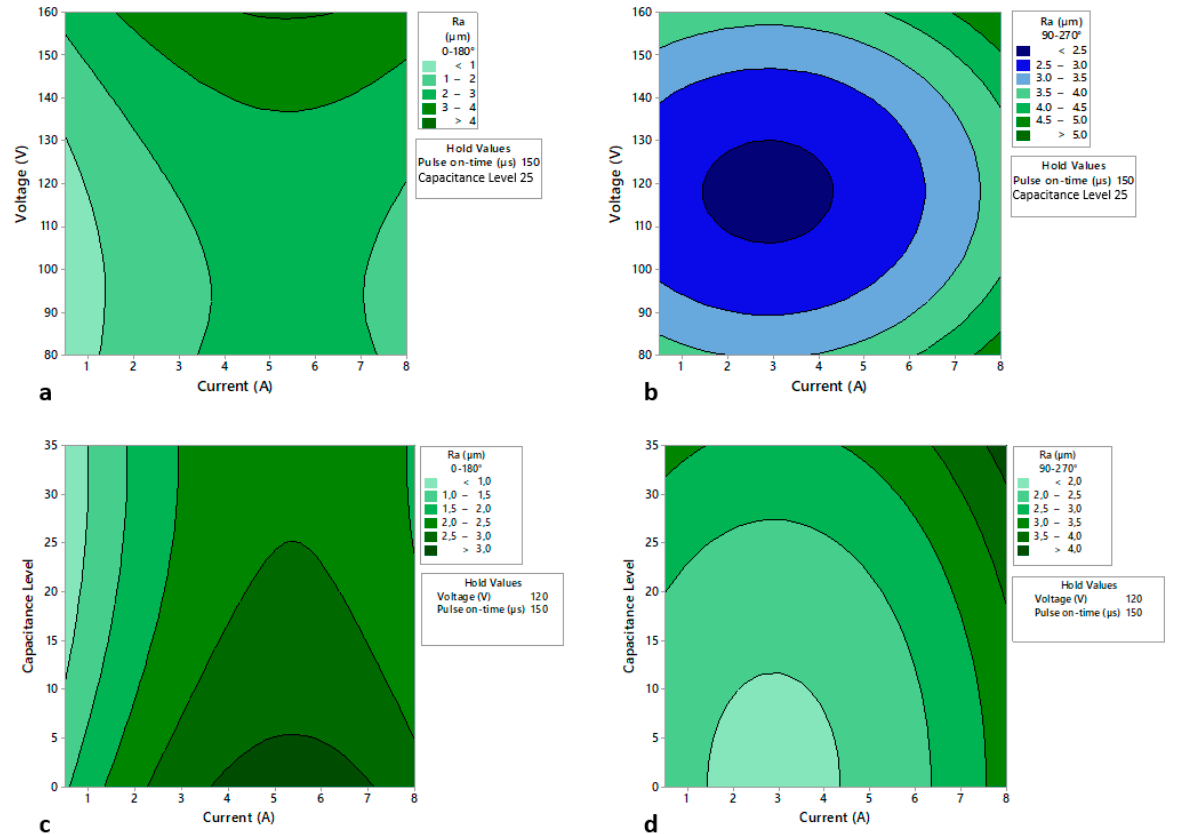
Figure 10. Contour diagrams that relate the surface quality in terms of Ra to the following machining parameters ( a ) Voltage and current for the 0–180 ◦ orientation; ( b ) Voltage and current for the 90–270 ◦ orientation; ( c ) Capacitance and current for the 0–180 ◦ orientation; ( d ) Capacitance and current for the 90–270 ◦ orientation.